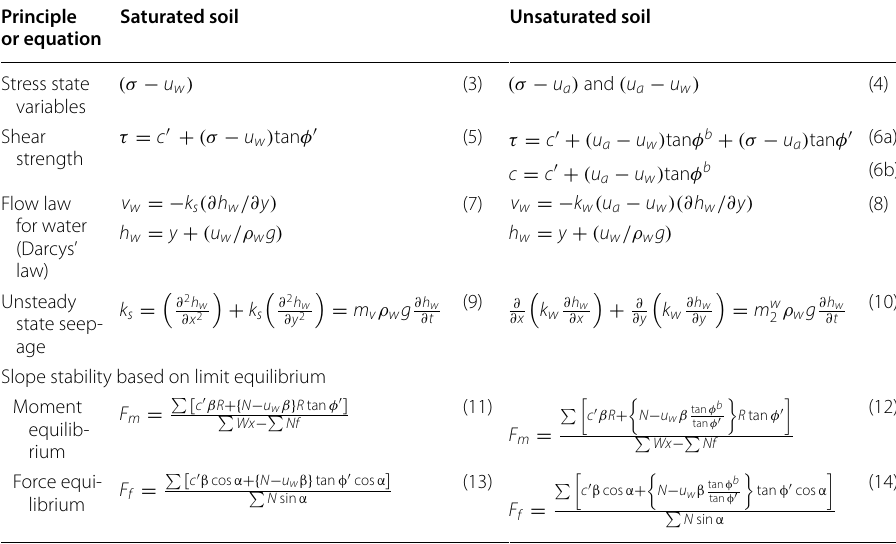
Table 1 Equations for saturated and unsaturated soil mechanics. Summarized from Fredlund and Rahardjo